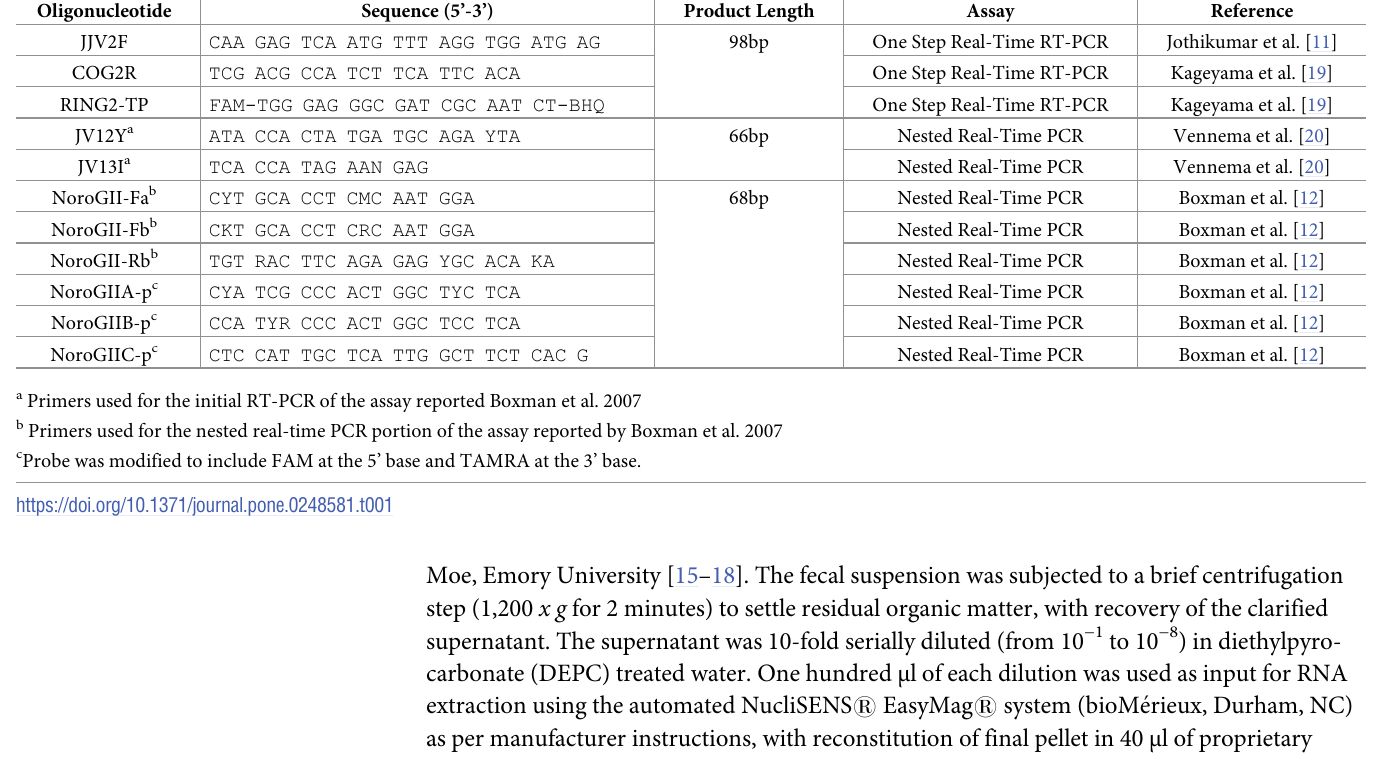
Table 1. Mismatches of the primers with Snow Mountain Virus are provided in Table 2, as the Table 2. Primer mismatches for Snow Mountain Virus used in this work.